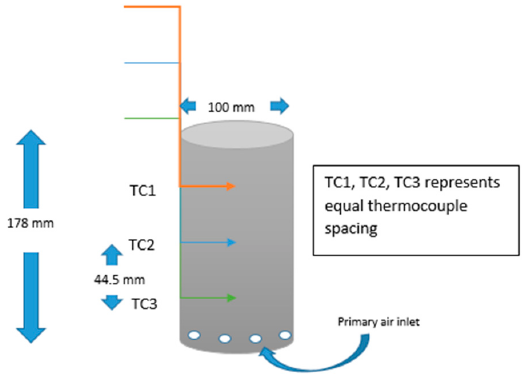
Figure 2. Combustion chamber details.